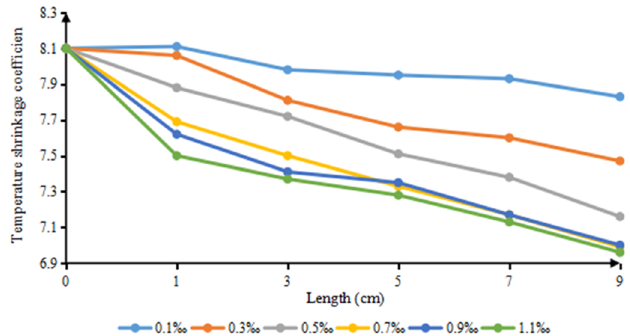
Figure 7. Effects of fiber length on the temperature shrinkage coefficient.